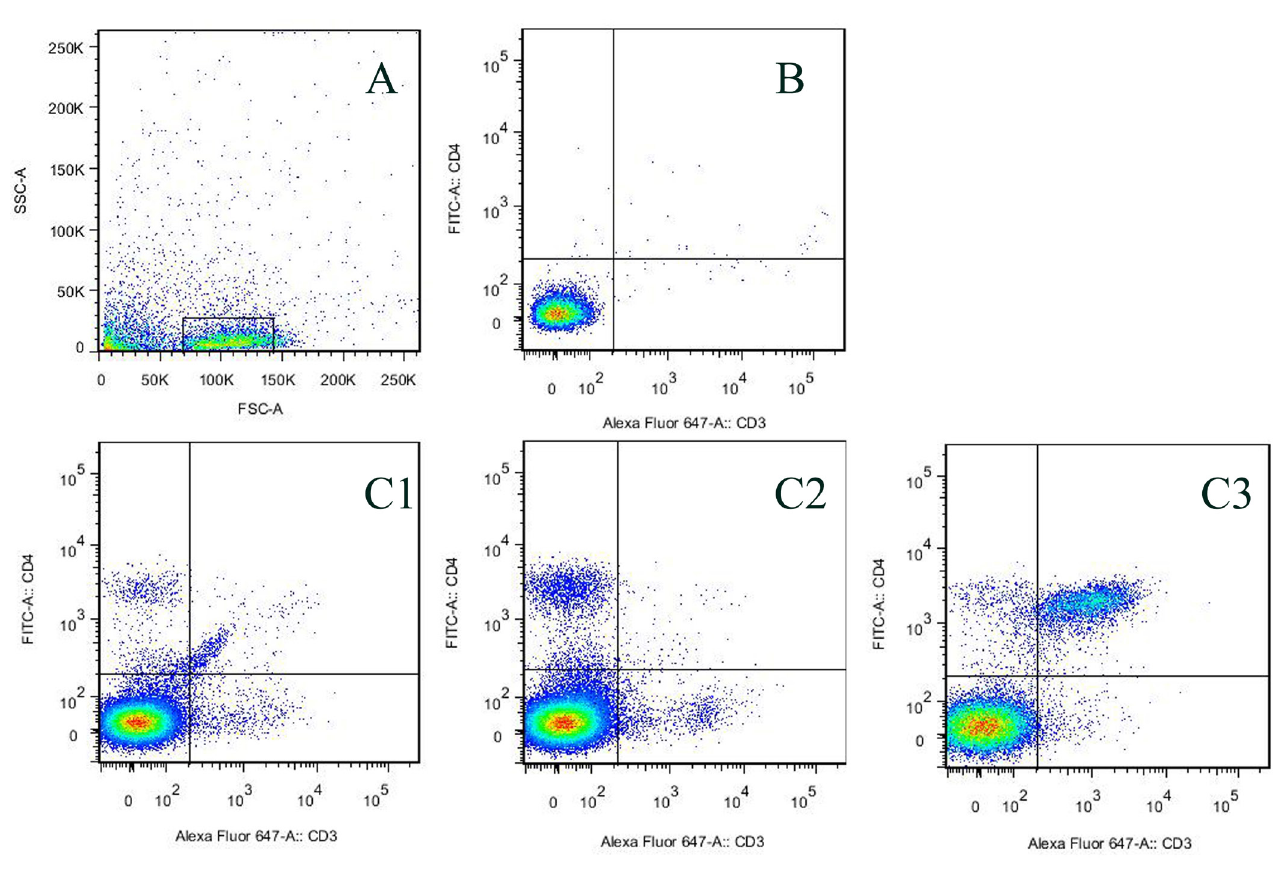
Fig. 3 - T helper cells in the five groups detected by flow cytometry. CD3=anti-CD3; CD4=anti-CD4; FITC-A=fluorescein isothiocyanate-area; FSC-A=forward scatter-area; SSC-A=side scatter-area.